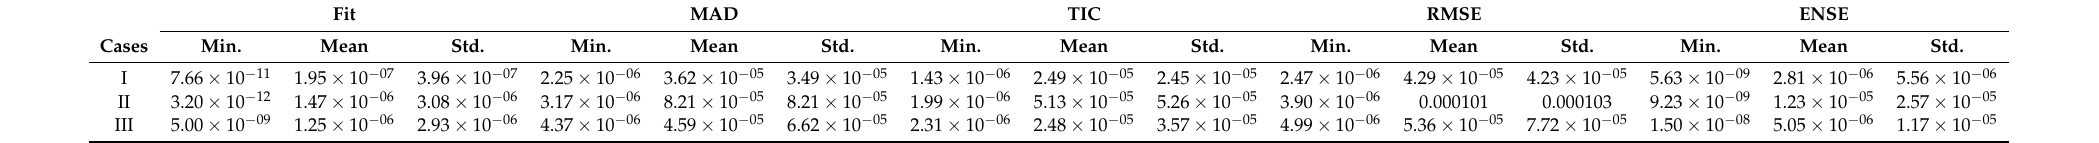
Table 15. Fitness values, MAD,TIC RMSE and ENSE for SCENARIO IV of the drainage